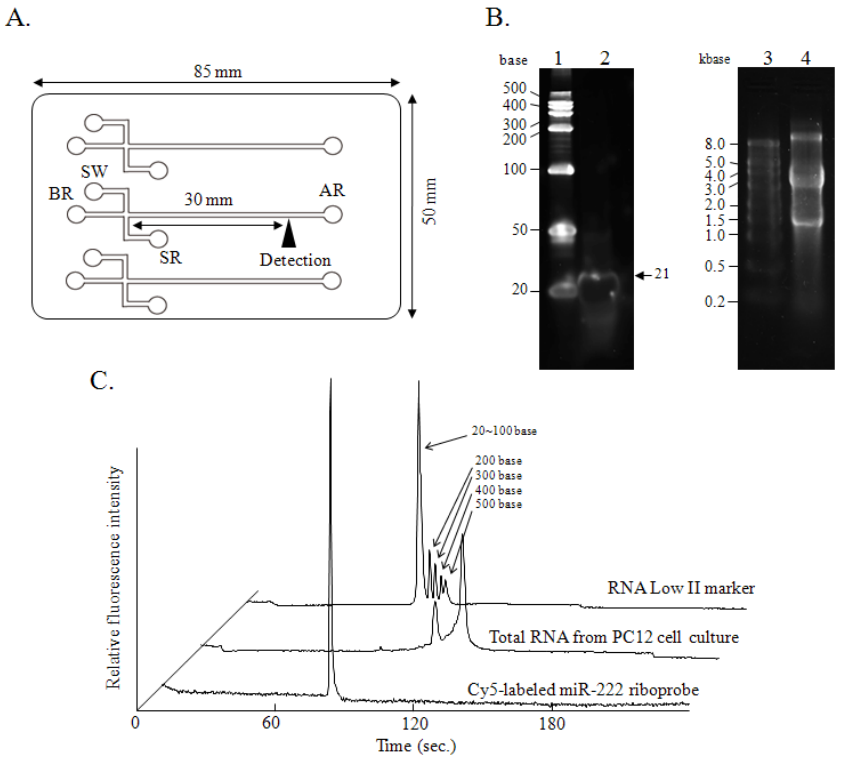
Figure 1. Design and size of the i -chip used for Hitachi SV1210 microchip electrophoresis. ( A ) Schematic diagram of the microchannel structure with cross-sections fabricated on a PMMA microchip, the i-chip (85 × 50 mm). The distances from each cross-section to the sample reservoir (SR), sample waste (SW), buffer reservoir (BR), and analysis reservoir (AR) well were 5.25, 5.25, 5.75, and 37.5 mm, respectively. ( B ) Separation of 1.0 µg of Cy5-labeled miR-22 riboprobe by 12% polyacrylamide gel electrophoresis (lane 2) and that of 10 µg of the total RNA (isolated from a PC12 cell culture) by 1.0% agarose gel electrophoresis (lane 4). RNA Low marker II (lane 1) and RNA High marker (lane 3)